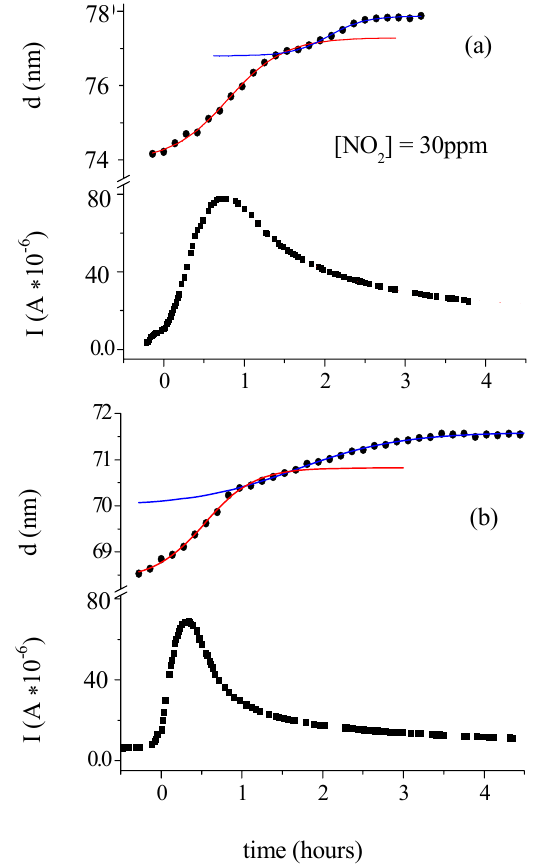
Figure 12 Time evolution of the morphological parameter d of (PcRu) current change when exposed to a 30 ppm NO flow(b)